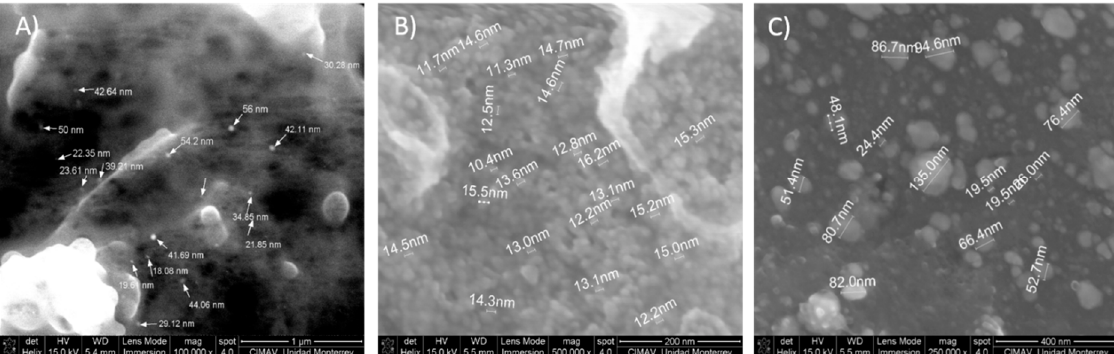
Figure 2. Micrographs of silver nanoparticles synthesized at different AgNO 3 concentrations: ( A ) concentration 0.01 mol/L (15 min, 1:1 AgNO 3 :MG); ( B ) concentration 0.2 mol/L (15 min, 1:1 AgNO 3 :MG); and ( C ) concentration 0.5 mol/L (15 min, 1:1 AgNO 3 :MG).